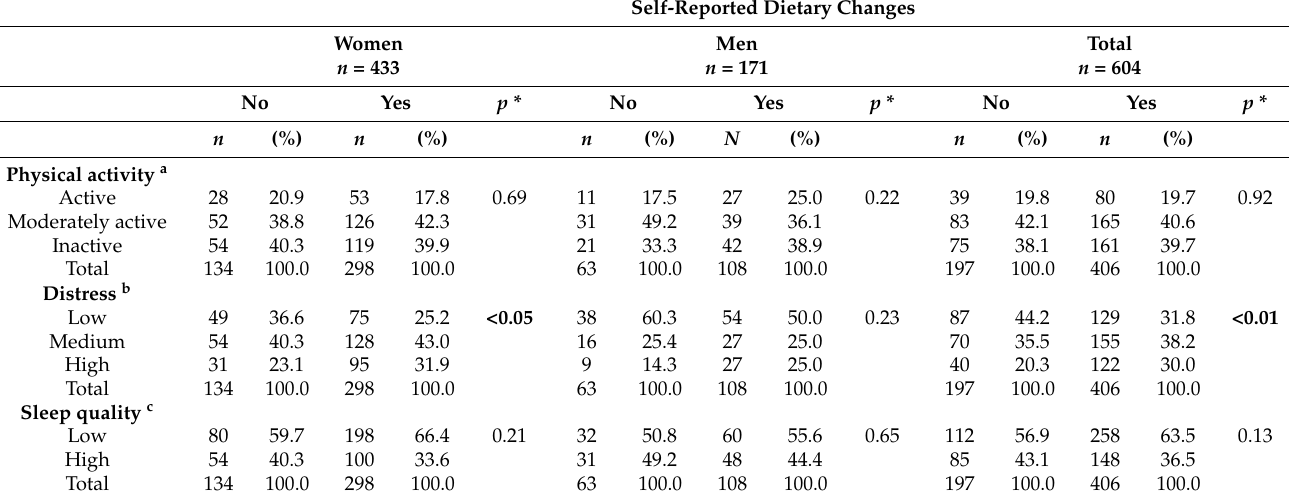
Table 4. Distribution of responses for self-reported dietary changes to physical activity, distress, and sleep quality in total subjects and by